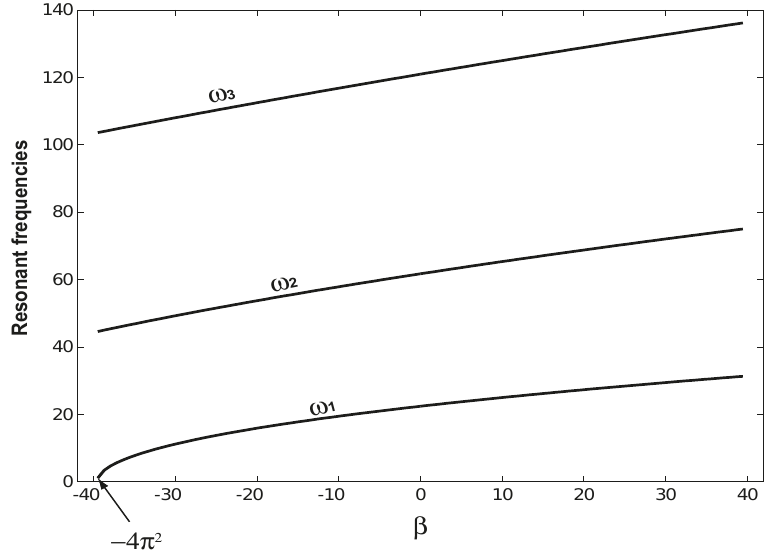
ω ) becomes zero, which 1